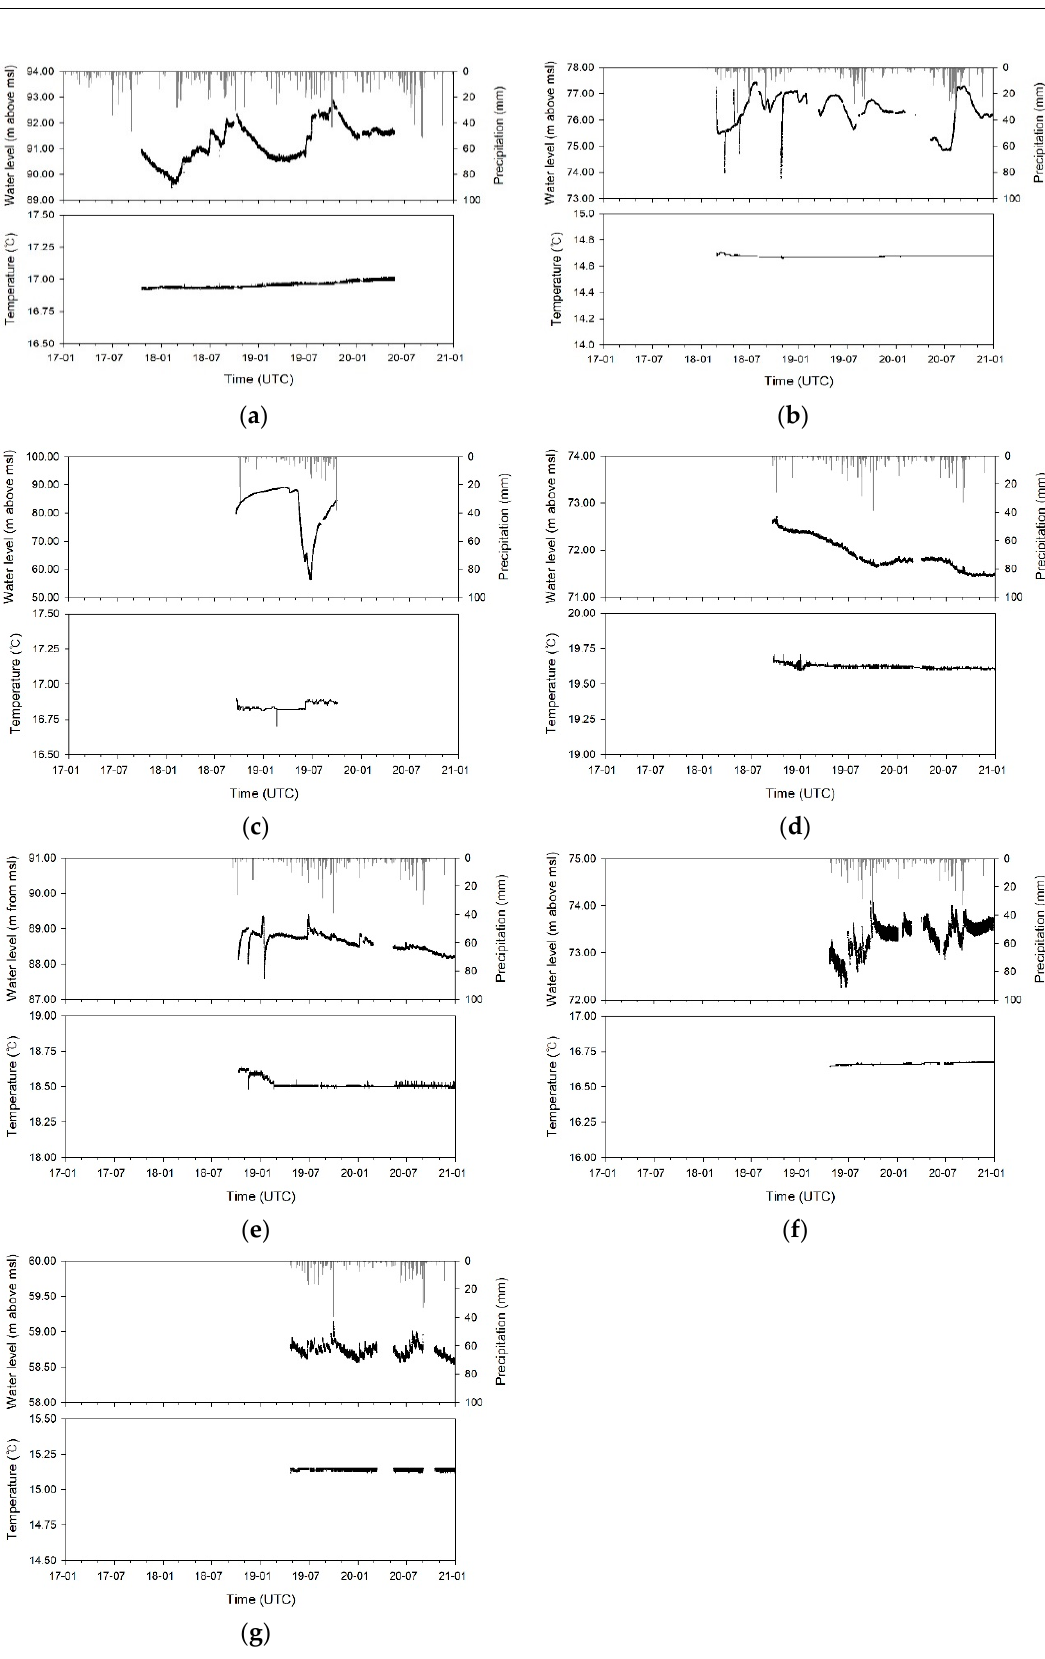
Figure 3. Groundwater data, including water levels and temperature, observed between 2018 and 2019 at monitoring stations ( a ) MW1, ( b ) MW2, ( c ) MW3, ( d ) MW4, ( e ) MW5, ( f ) MW6, and ( g ) MW7. The vertical bar chart represents hourly precipitation data and “msl” is the abbreviation of mean seawater level.